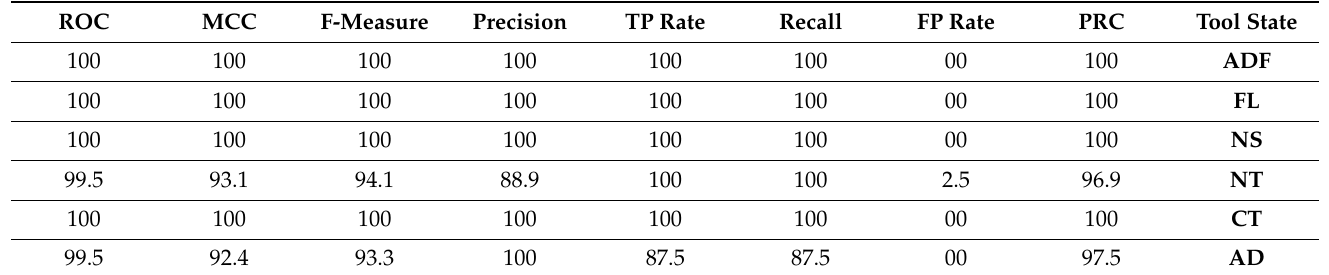
Table 5. Performance indicators of classification considering training dataset.